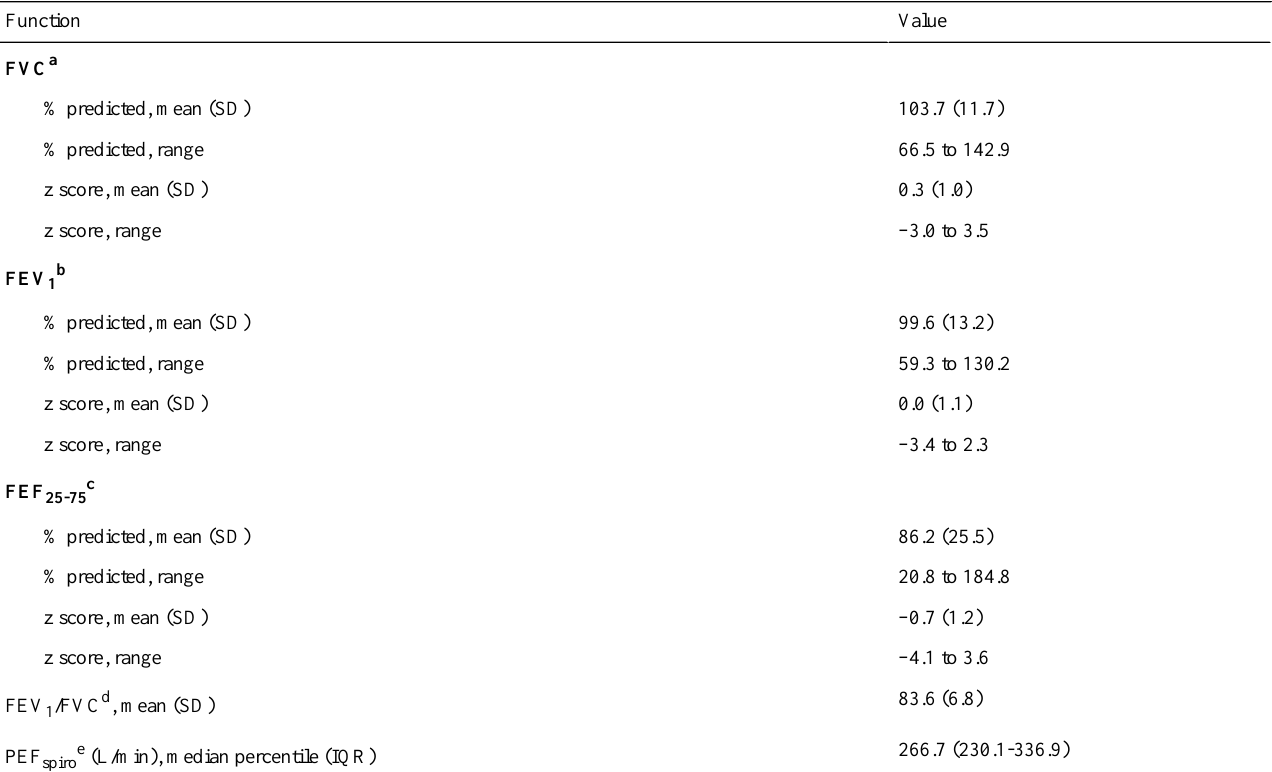
Table 2. Baseline lung function assessed by conventional spirometry (n=158).